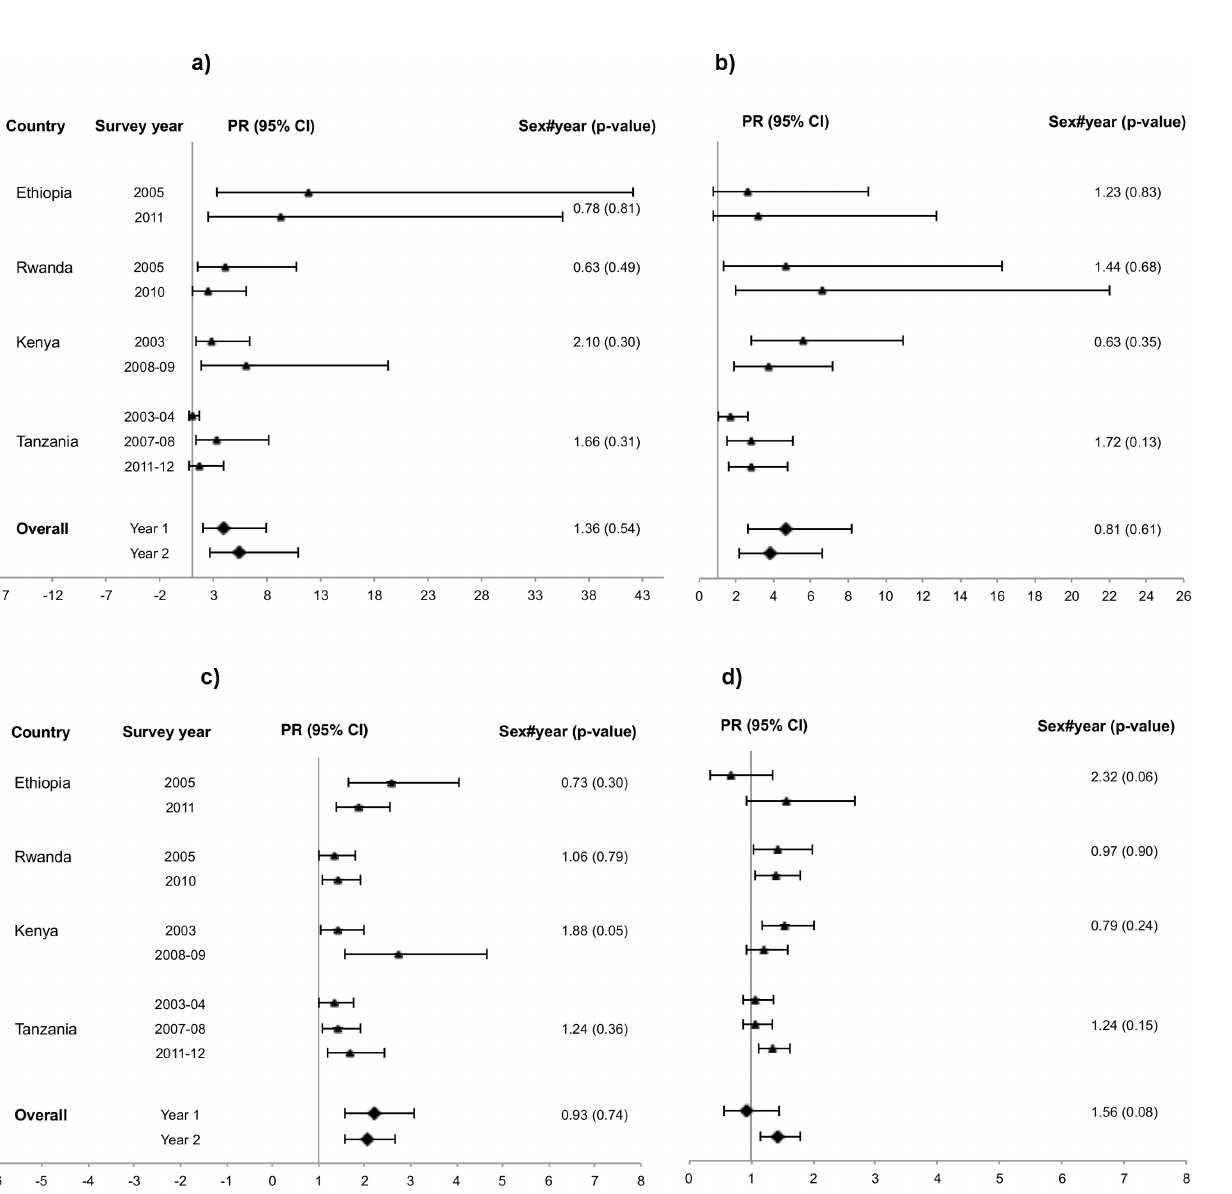
Fig 2. Eastern Africa, age-adjusted female: male HIV prevalence ratios. (a) Urban, 15 – 24 years. (b) Rural, 15 – 24 years. (c) Urban, 25 – 49 years (d) Rural, 25 – 49 years.